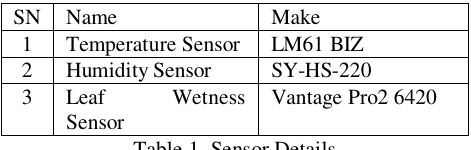
Figure 1. Mote of AgriSens ( GeoSense, 2011 ) Different sensors used in AgriSens are Temperature, Humidity, and Leaf Wetness. The details of sensors are specified in Table 1 (Neelamegam et al., 2007).